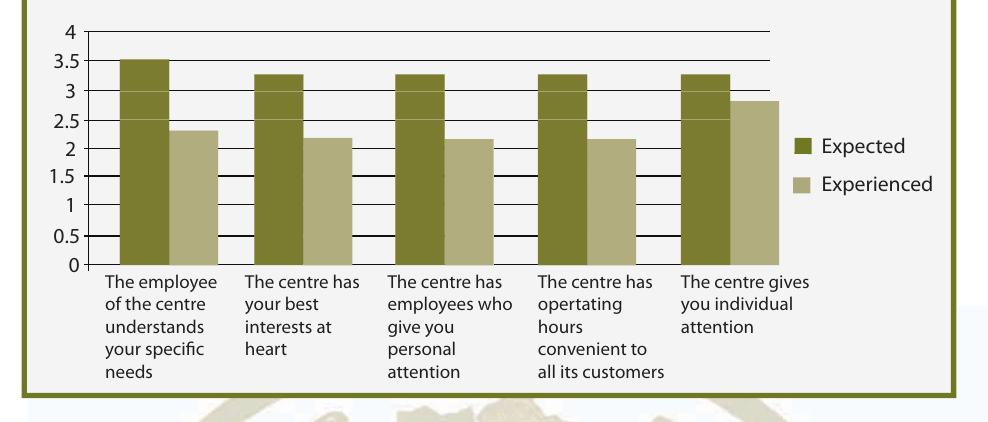
ASSURANCE AND PROFESSIONALISM IN E